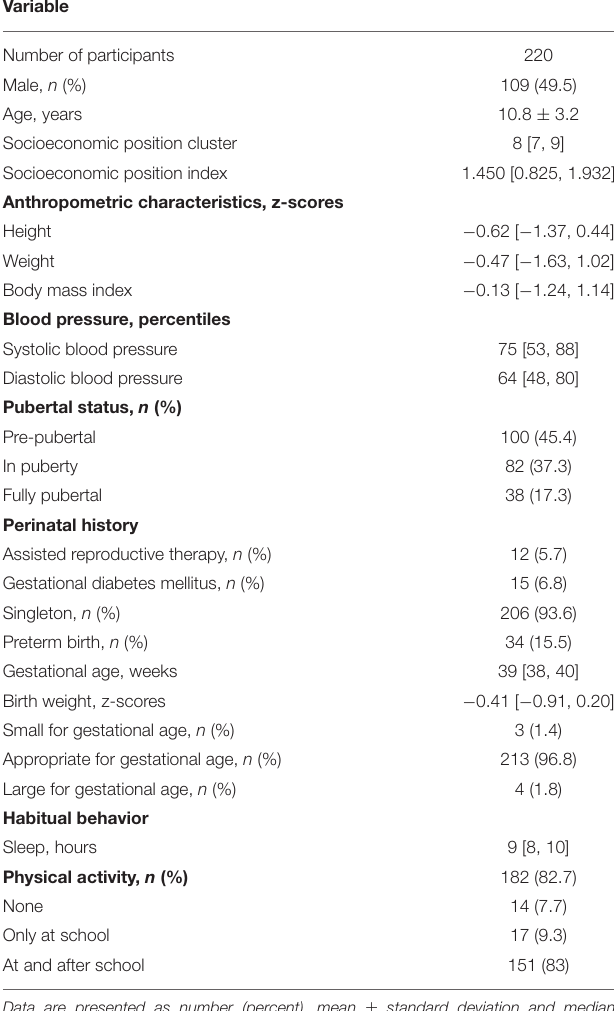
TABLE 1 | Sociodemographic, perinatal, and pre-COVID-19 characteristics of 220 children and